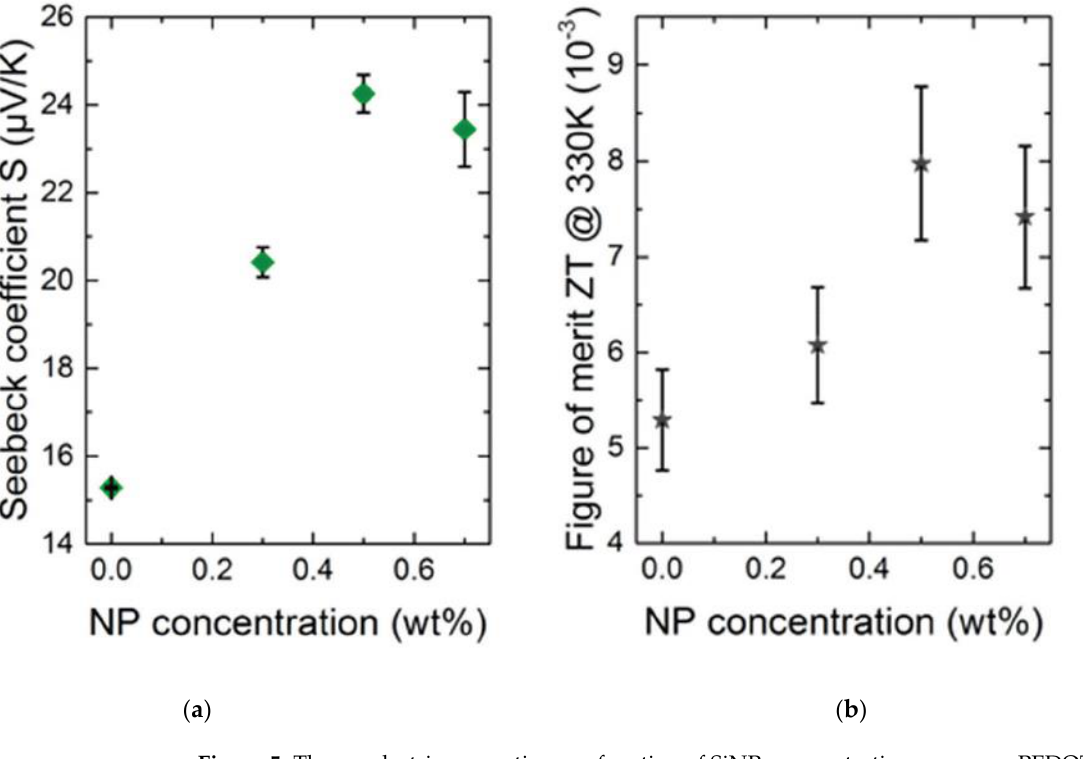
Figure 5. Thermoelectric properties as a function of SiNPs concentration grown on PEDOT:PSS thin films. ( a ) Seebeck coefficient for PEDOT:PSS/SiNPs at different concentrations of SiNPs. ( b ) Figure of merit values for PEDOT:PSS/SiNPs thermoelectric samples at different concentrations of SiNPs. Reprint with permission [5324900718582]; Copyright Year 2022, John Wiley and Sons Publisher [13].